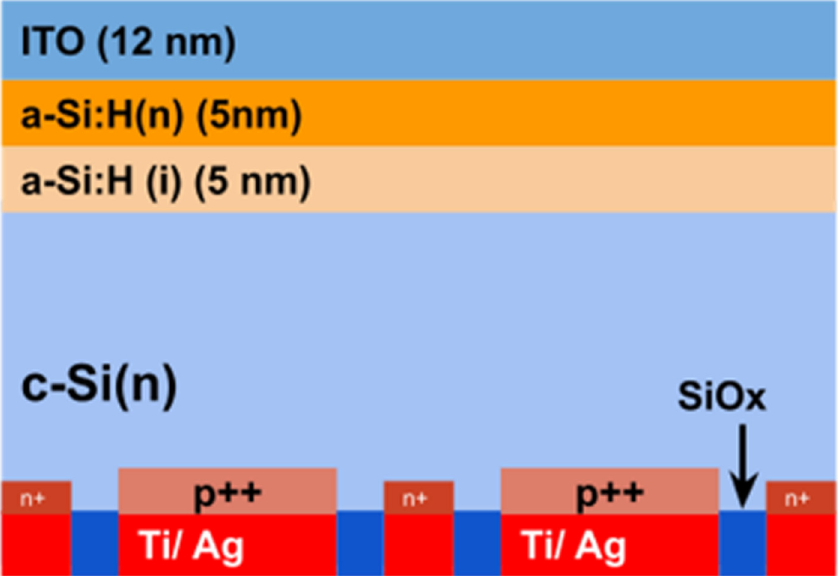
Fig. 7. Architecture of the Si-IBC bottom subcells. It is a conventional Si-IBC solar cell with the top surface passivated by a stack of thin intrinsic and doped hydrogenated amorphous silicon layers and covered with